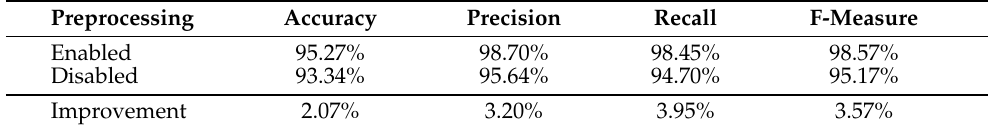
Table 4. Influence of